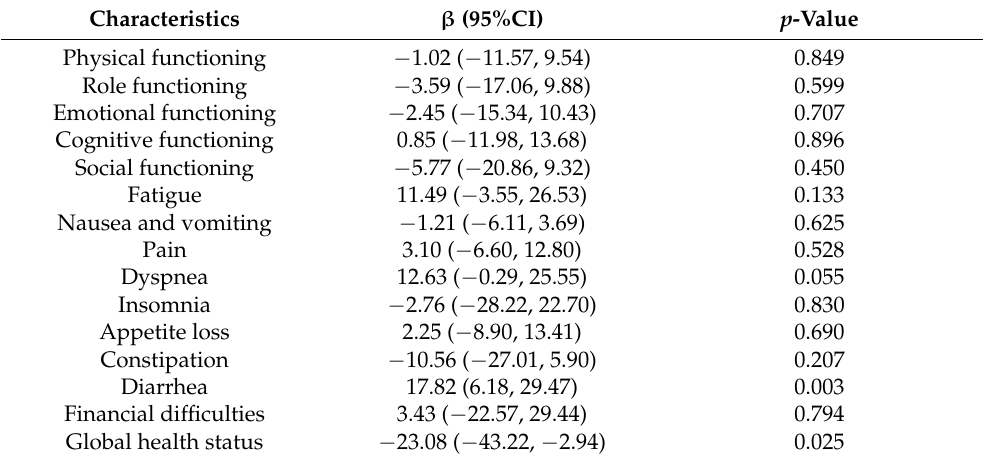
Table 2. Interaction between sarcopenia and the surgical approach on postoperative health-related quality of life.